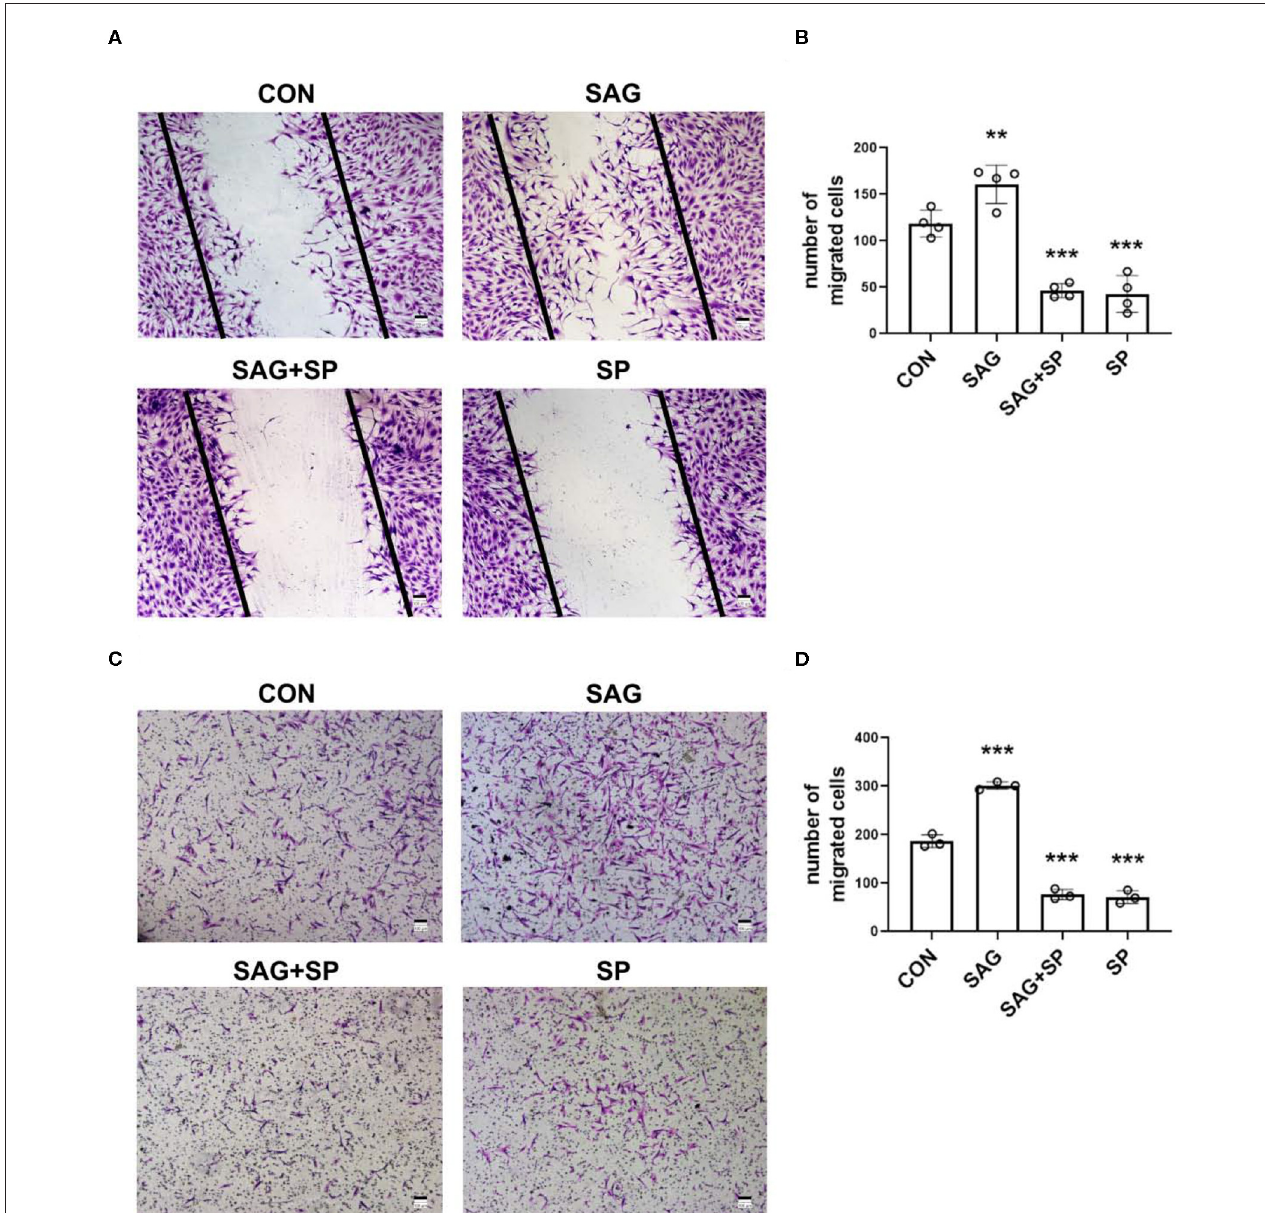
FIGURE 4 | SHH agonist promotes FLSs migration via JNK. (A–D) FLSs migration was evaluated by wound healing assay and chemotaxis assay. In the wound healing assay, FLSs were treated with SAG (1 µ M) or SAG in the presence of SP600125 (20 µ M) for 12h after scratching ( n = 4) (A,B) . In the chemotaxis assay, FLSs were planted in the upper chambers. DMEM containing 10% FBS, SAG (1 µ M) with or without SP600125 (20 µ M) was added to the lower compartment. Cells were treated for 16h ( n = 3) (C,D) . The numbers of migrated cells in wound healing assay and chemotaxis assay were calculated. FLSs in control group were treated with vehicle (DMSO supplemented in DMEM with 2.5% FBS in wound healing assay and 10% FBS in chemotaxis assay). The results are shown as the mean ± S.D. Data were analyzed using ANOVA and post hoc comparisons were made by Dunnett’s test (B,D) . ** P < 0.01 vs. control group. *** P < 0.001 vs. control group. CON, control group; SP,